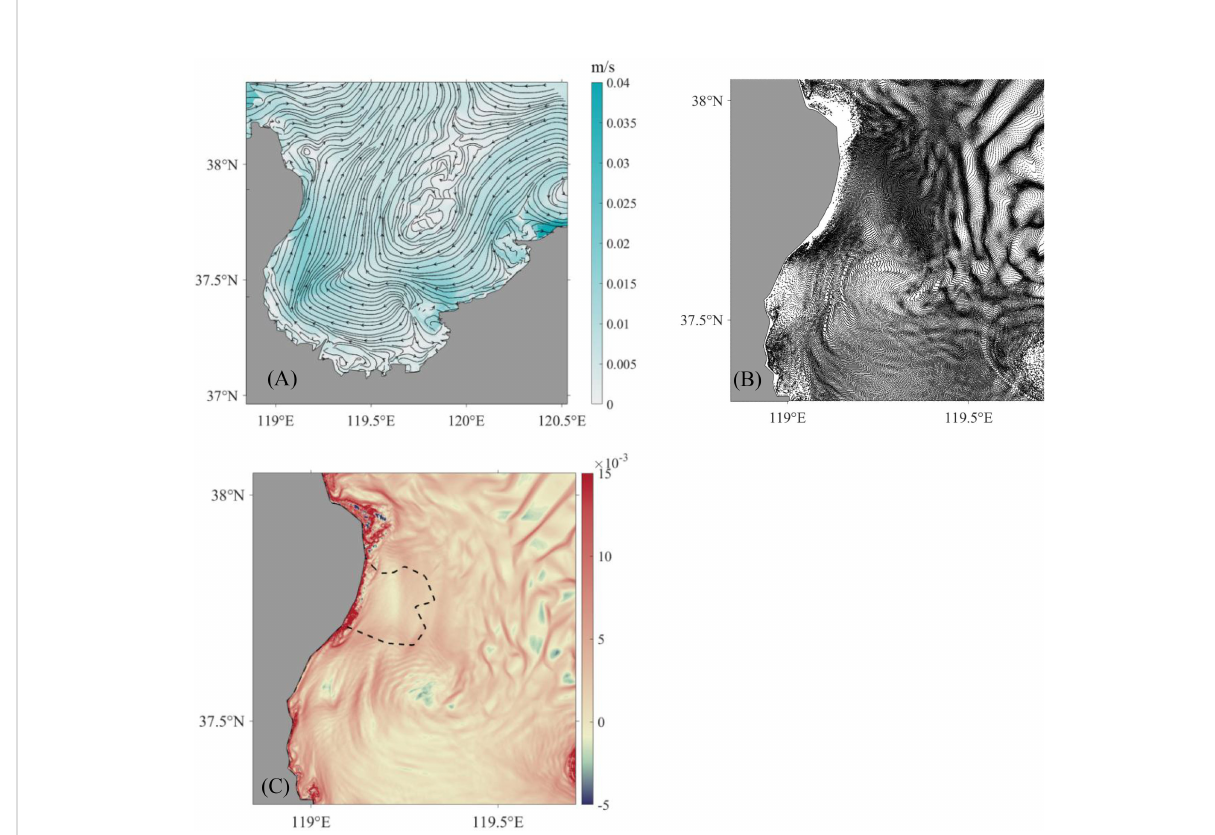
FIGURE 8 The Lagrangian residual current (A) , particle distribution after 300 h (B) , and backward FTLE fi eld for 200 h (C) obtained from the model after adjusting the coastline at the time are consistent with the high tide in Figures 5 –